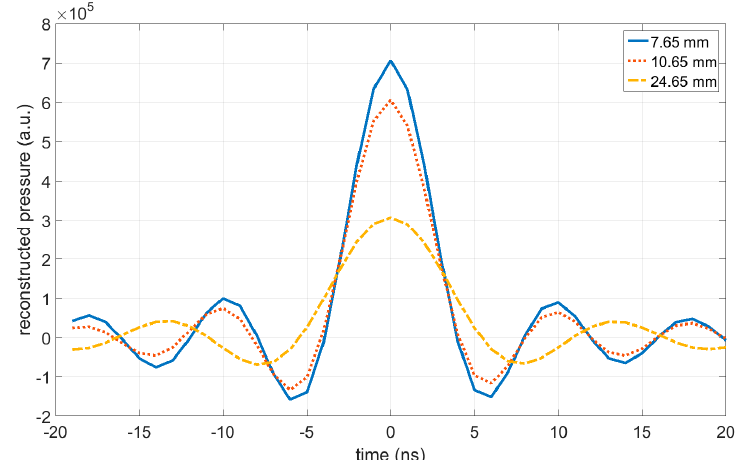
Figure 4. Reconstructed ideal waves according to Equation (10) from the measured acoustic pressure signals shown in Figure 2. According to Equation (11), these sinc functions have their maximum at time zero (the time scale was shifted for each signal, which allows plotting all of the signals on the same time scale) and the zero points are at ± δ resolution . c (cid:3030)